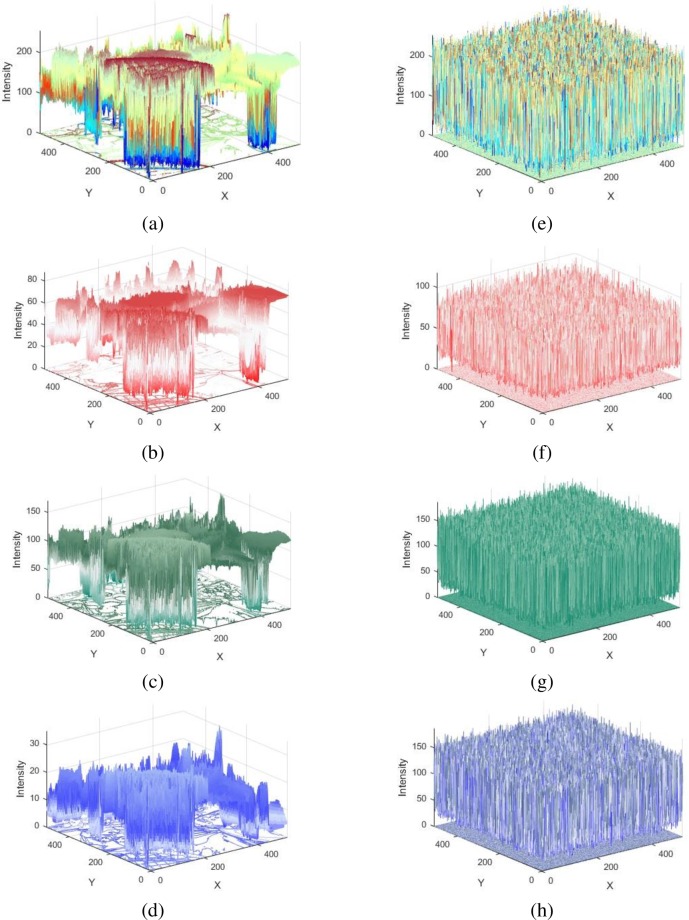
Three dimensional color intensity histograms of Fruit image of size 512×512.(a) 3D plain image histogram. (b) Red component histogram in 3D. (c) Green component histogram in 3D. (d) Blue component histogram in 3D). (e) 3D Encrypted image histogram. (f) Encrypted Red component histogram in 3D. (g) Encrypted Green component histogram in 3D. (h). Encrypted Blue component histogram in 3D.